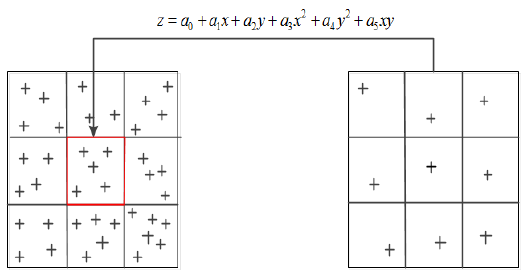
Figure 2. Fitting process with minimum points in neighborhood grids.